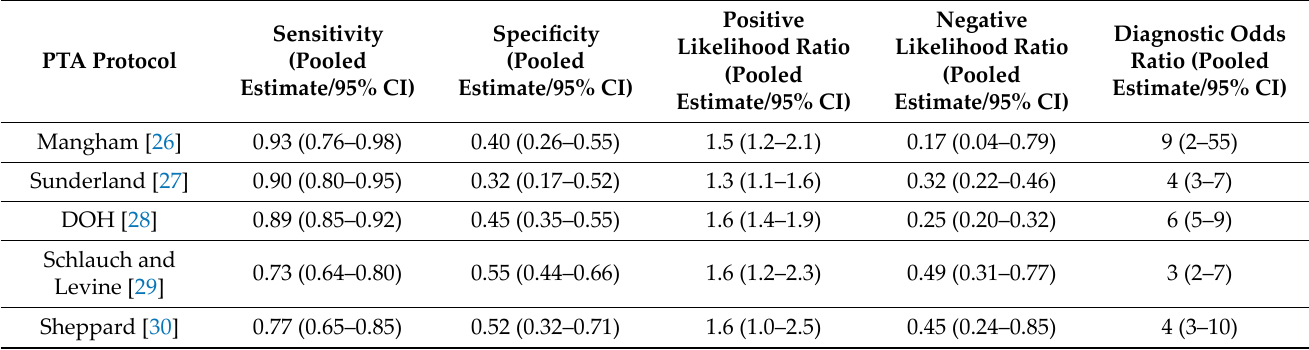
Table 3. Pooled estimates of diagnostic accuracy parameters for the included PTA